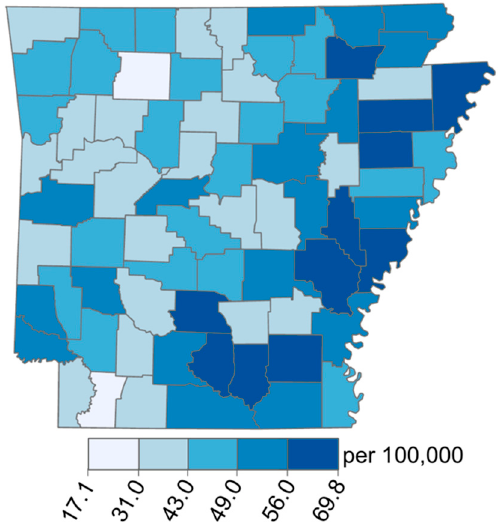
Figure 1. Map of age-adjusted colorectal cancer incidence by county in AR.